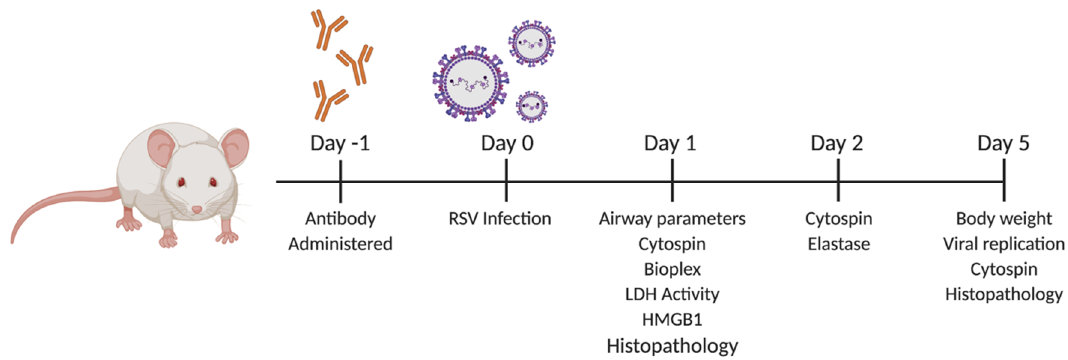
Figure 1. Experimental schematic of TNFR blockade for Figures 2–5. The 10 to 12-week-old female BALB / c mice were intranasally inoculated 24 h prior to infection with 80 µ g of control IgG (IgG), anti-TNFR1 (40, 80, and 160 µ g), or anti-TNFR2 (40, 80, and 160 µ g). All samples were diluted in sterile PBS. At day 0, mice were infected with 5 × 10 6 PFU RSV. Following infection, mice were monitored daily for changes in clinical disease (e.g., body weight). Experiments were performed at the listed time points using lung tissue or bronchoalveolar lavage fluid (BALF) as stated elsewhere.